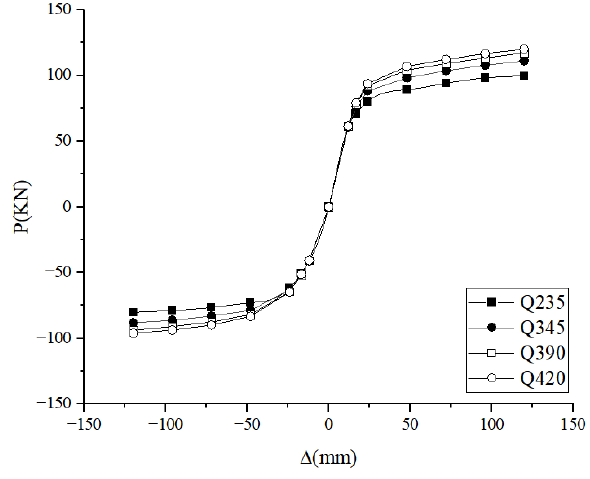
Figure 22. Strength of U-shaped steel.